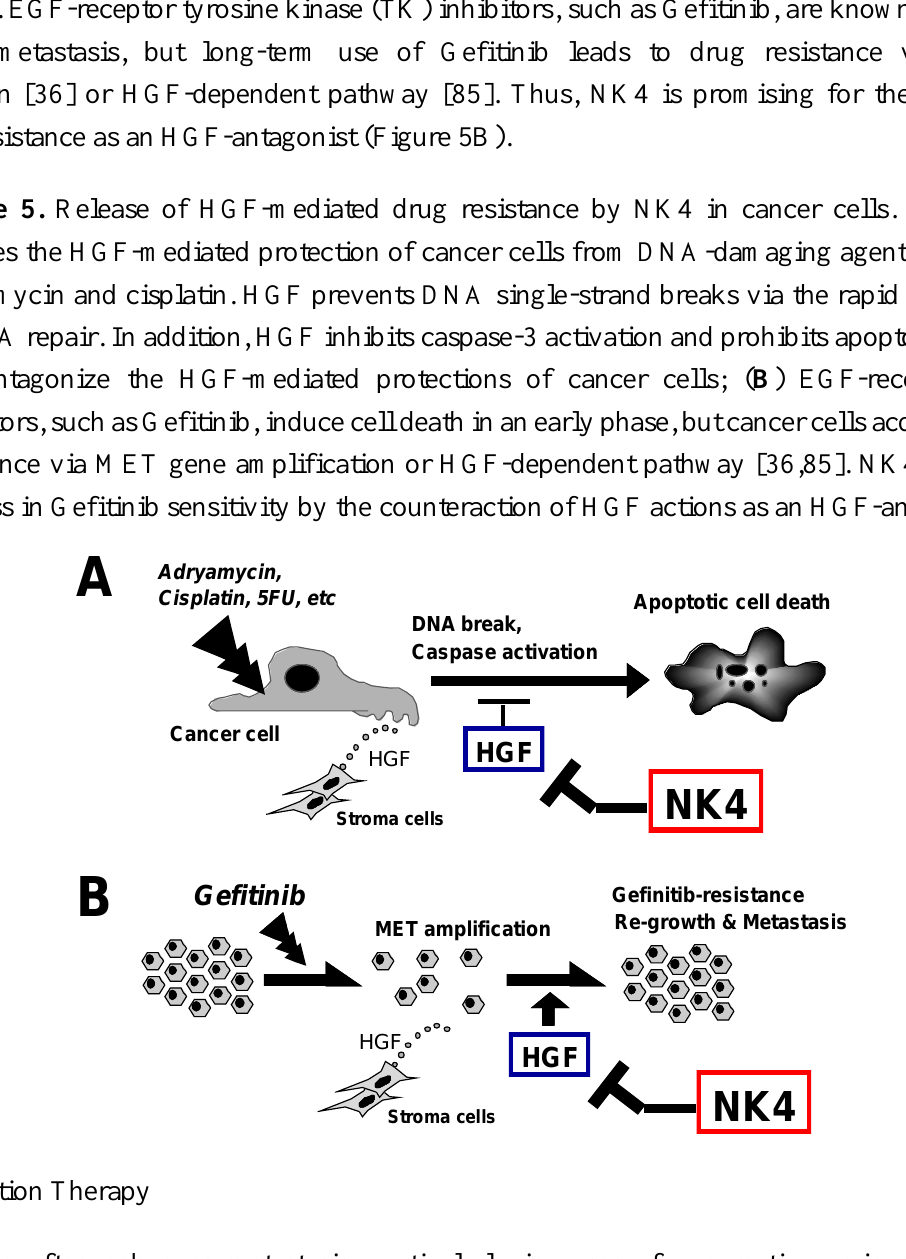
Figure 5. Release of HGF-mediated drug resistance by NK4 in cancer cells. ( A ) NK4 releases the HGF-mediated protection of cancer cells from DNA-damaging agents, such